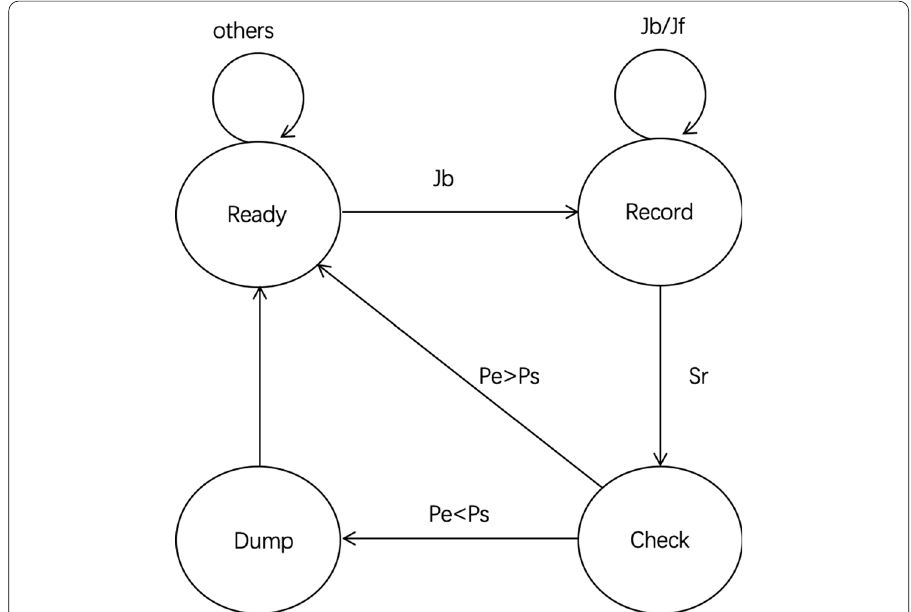
Fig. 3 The construction of complete-jump behavior based on DFA